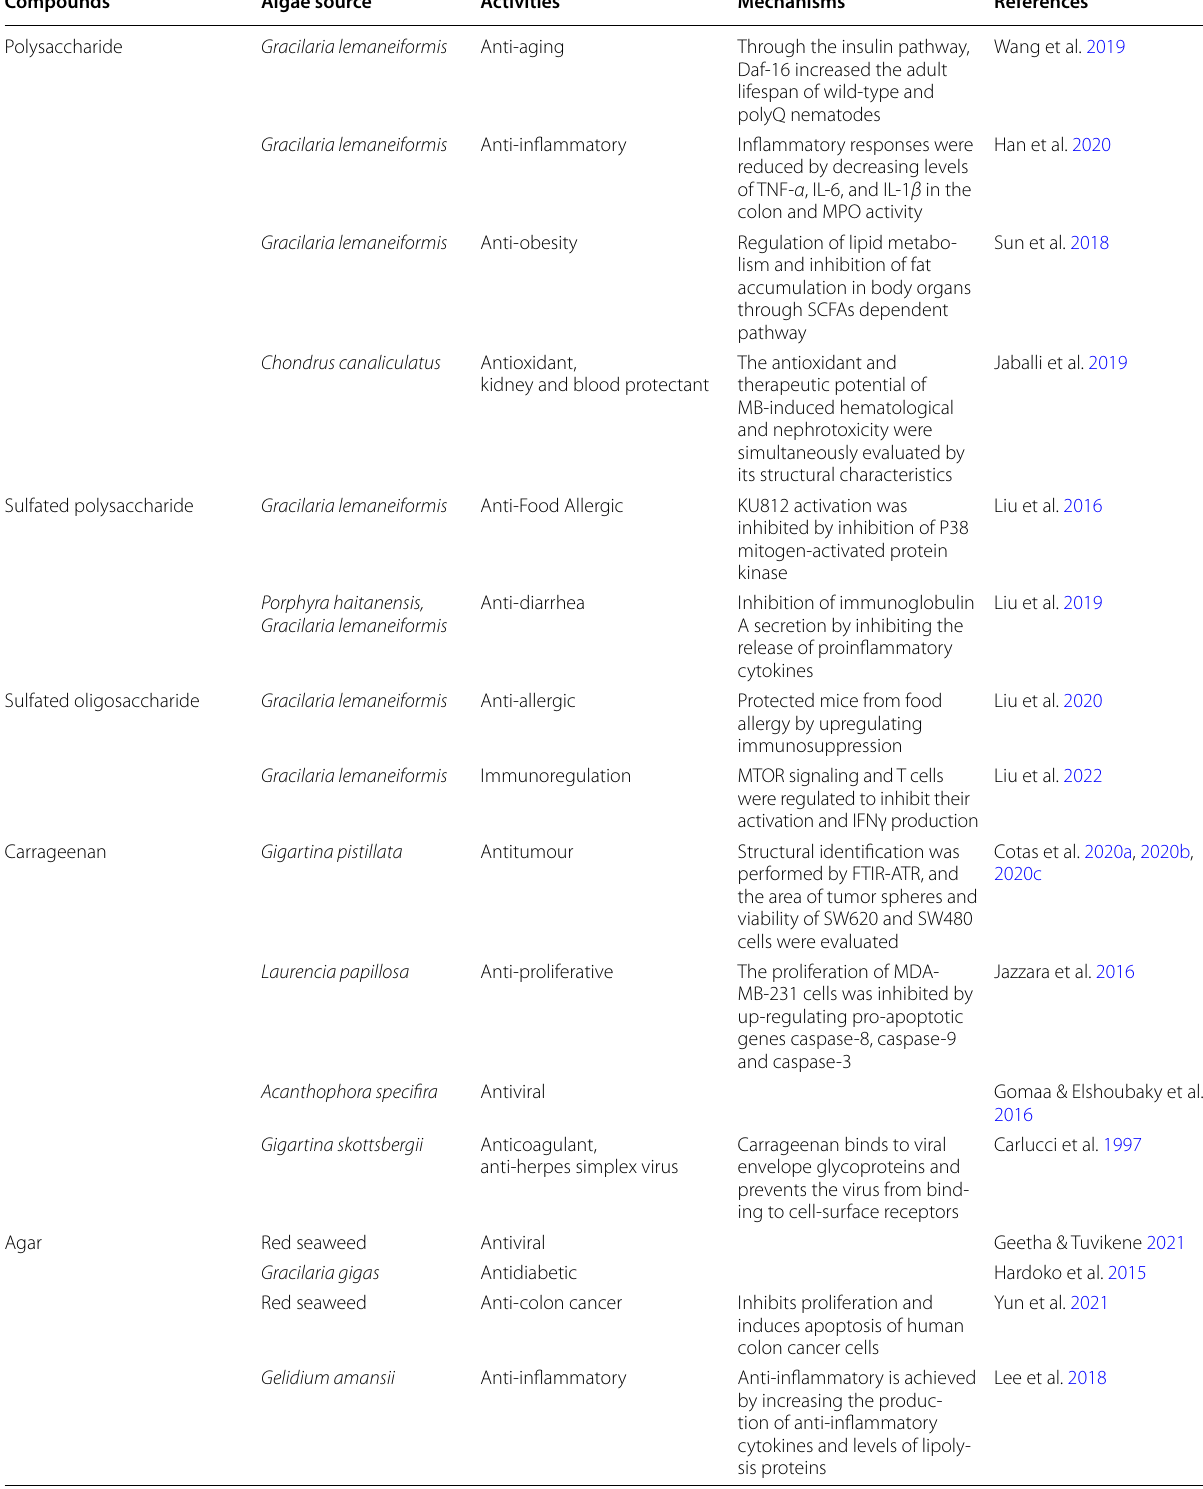
Table 2 The bioactivity and characteristics of red seaweeds